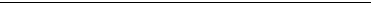
(cid:12)gure 3. The case of V is slightly di(cid:11)erent because there is no lattice calculation that 4